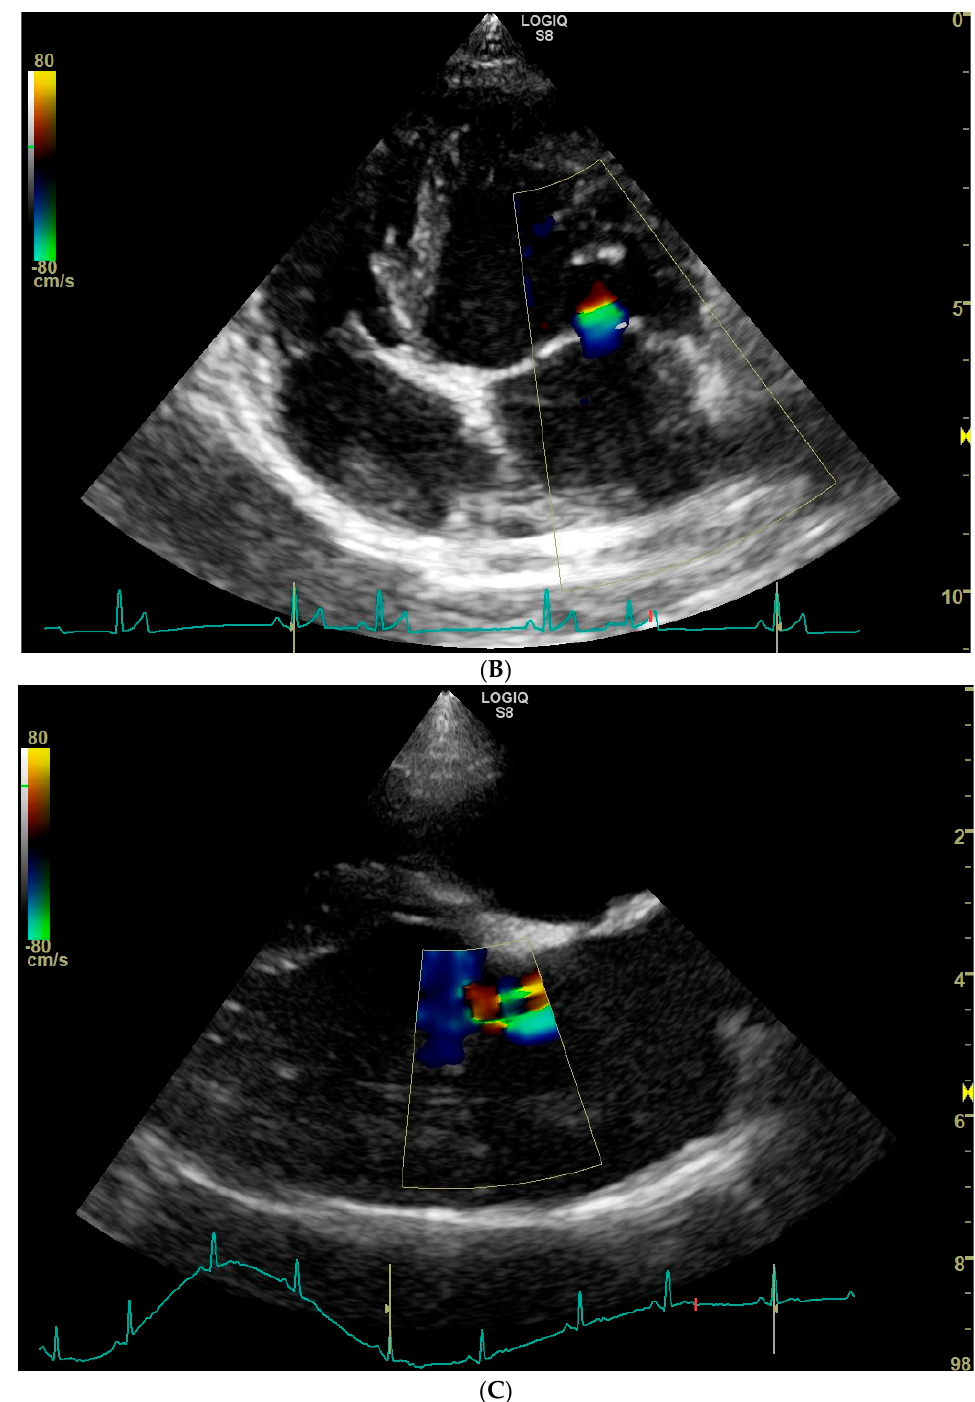
Figure 1. Color Doppler echocardiographic images (systolic frames) of trivial mitral valve regurgitation jets in three clinically healthy Labrador retrievers without heart murmur. ( A ). Standard right parasternal four-chamber view showing a central jet. ( B ). Standard left parasternal four-chamber view showing a central jet. ( C ). Standard right parasternal four-chamber view showing two eccentric jets.